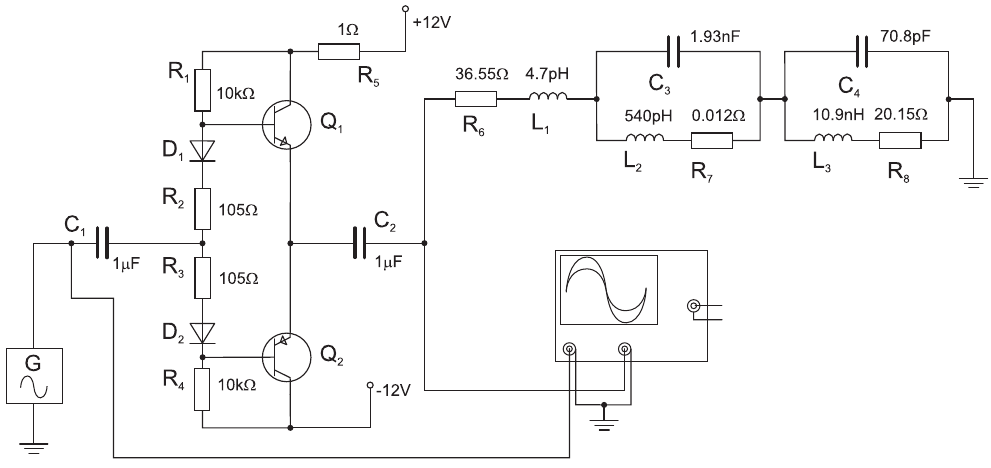
Figure 10. AB-class amplifier with